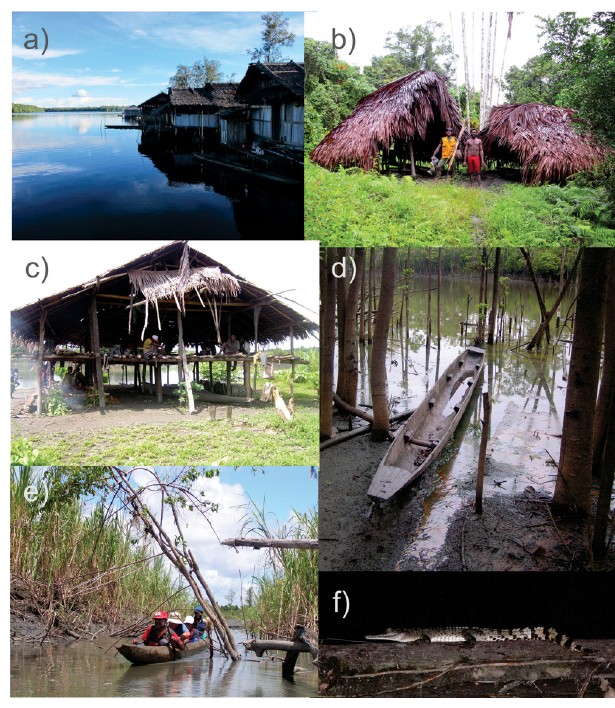
Fig. 5 . Contexts and activities associated with autonomous monitoring. (a) Settlements are strategically located and look out over the most valued fishing grounds (Yoke, MB); (b) regular camping sites include huts and gardens, here on the village territory boundary (Metaweja, MB); (c) the home of an Ijabait hereditary guardian by the Tariku (Rouffaer) River (Kay, DS); (d) anyone accessing these flood plain territories leaves visible tracks in the soft substrate (a tributary of the Tariku near Kay, DS); (e) accessing the resource-rich lakes is easiest via specific channels that can be closely monitored (Kay, DS); (f) monitoring of crocodiles is easiest using strong torch light at night. This is a method that people have adopted from a Food and Agriculture Organization of the United Nations team that assessed crocodile populations in the 1980s (Kay,